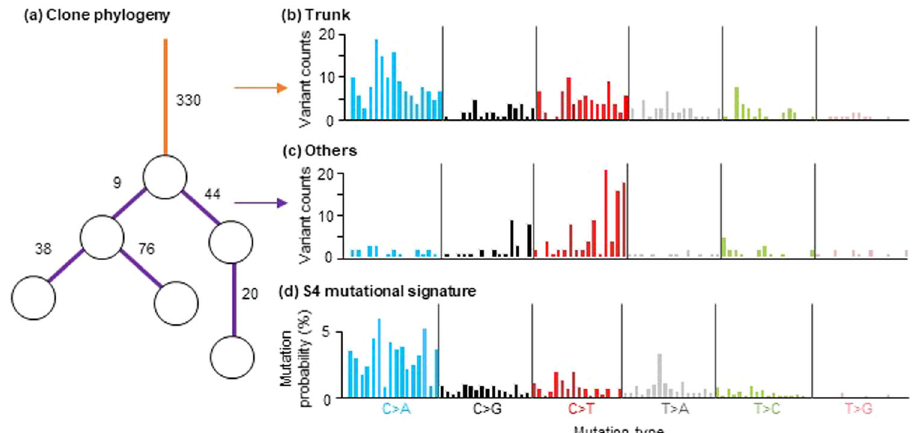
Fig. 1 Clone phylogeny and variant counts from a lung cancer patient. a Clone phylogeny of 6 clones. Clones are shown with circles. Numbers along branches represent variant counts. b , c Observed variant counts in the trunk (orange branch; b ) and the other branches (purple; c ). The data were obtained from Jamal-Hanjani et al. (2017) (CRUK0025 dataset). d COSMIC signature S4 is characterized by many C to A